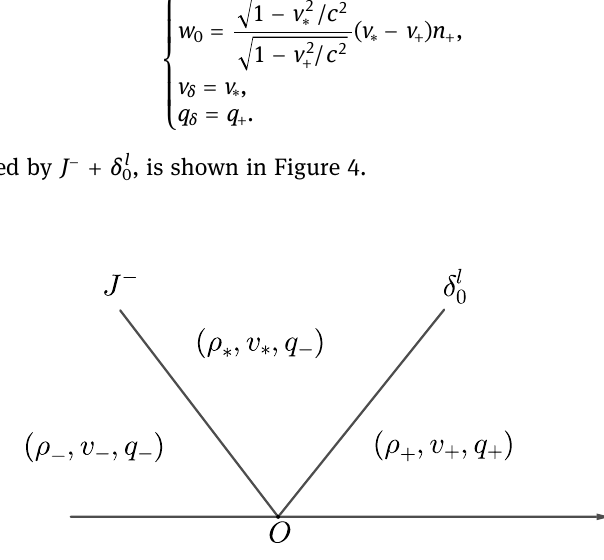
Figure 4: Riemann solution: + J δ l − 0